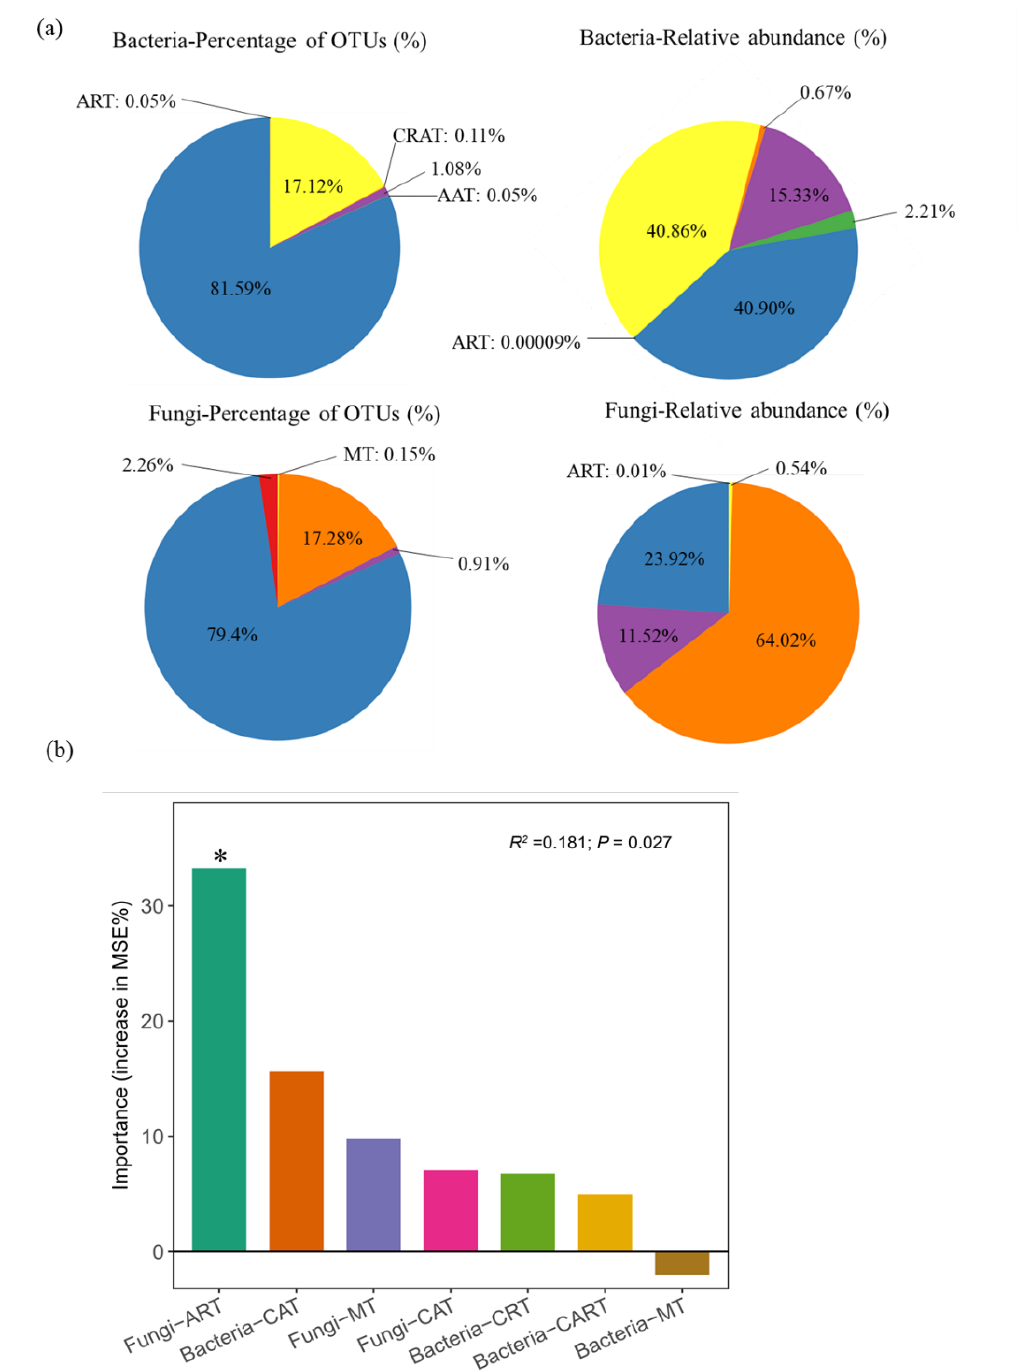
Figure 7. The percentage of OTUs and relative abundance of six categories of microbial taxa ( a ). The random forest regression model indicates the main microbial drivers of soil multifunctionality ( b ). MSE is the mean square error. This accuracy importance measure is computed for each tree and averaged over the forest (5000 trees) and determined by the increase in the MSE. * p < 0.05 on the bar shows that the associated microbial taxa have a significant effect on soil multifunctionality. ART: always rare taxa; CRT: conditionally rare taxa; AAT: always abundant taxa; CAT: conditionally abundant taxa; CRAT: conditionally rare and abundant taxa; MT: moderate taxa.